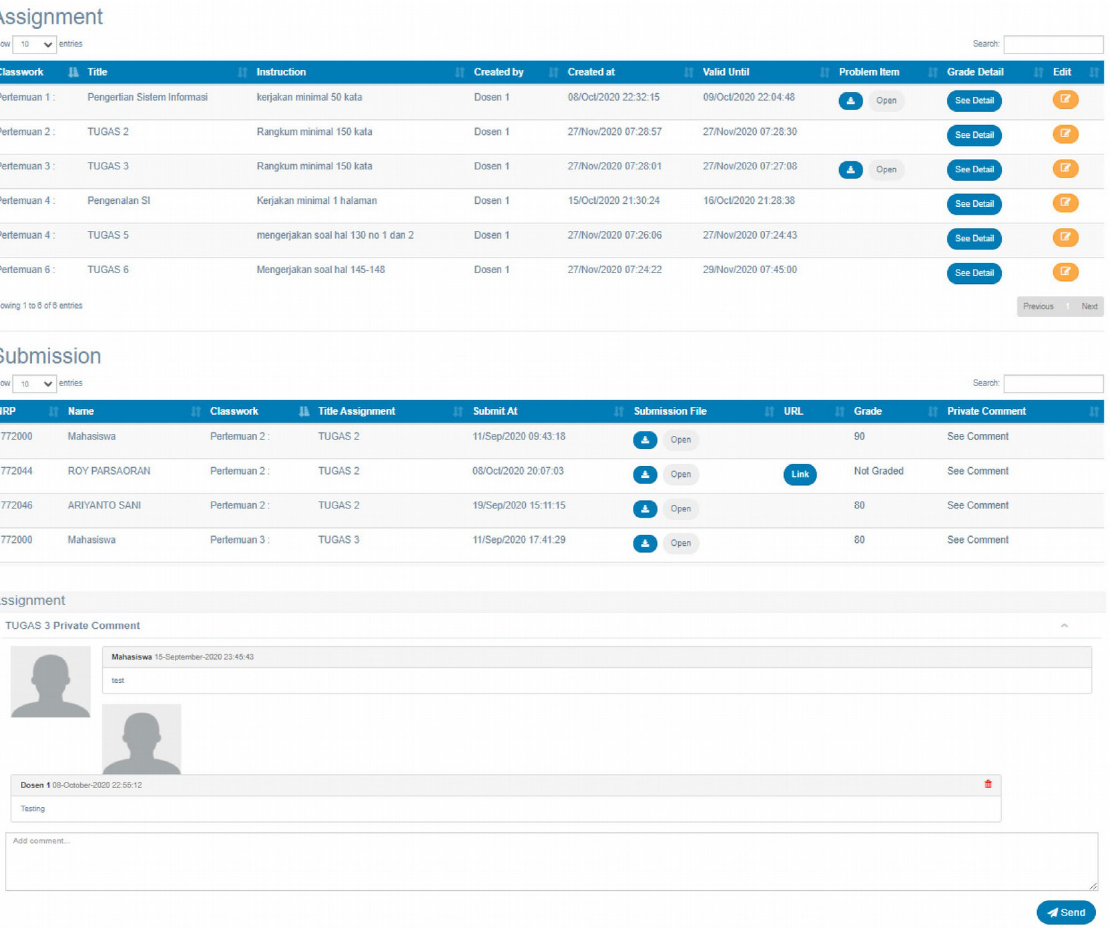
Figure 5. Assignment sub-system which provides the possibilities of interaction by using comments as feedback to students and extending it as a discussion topic in a general discussion in a